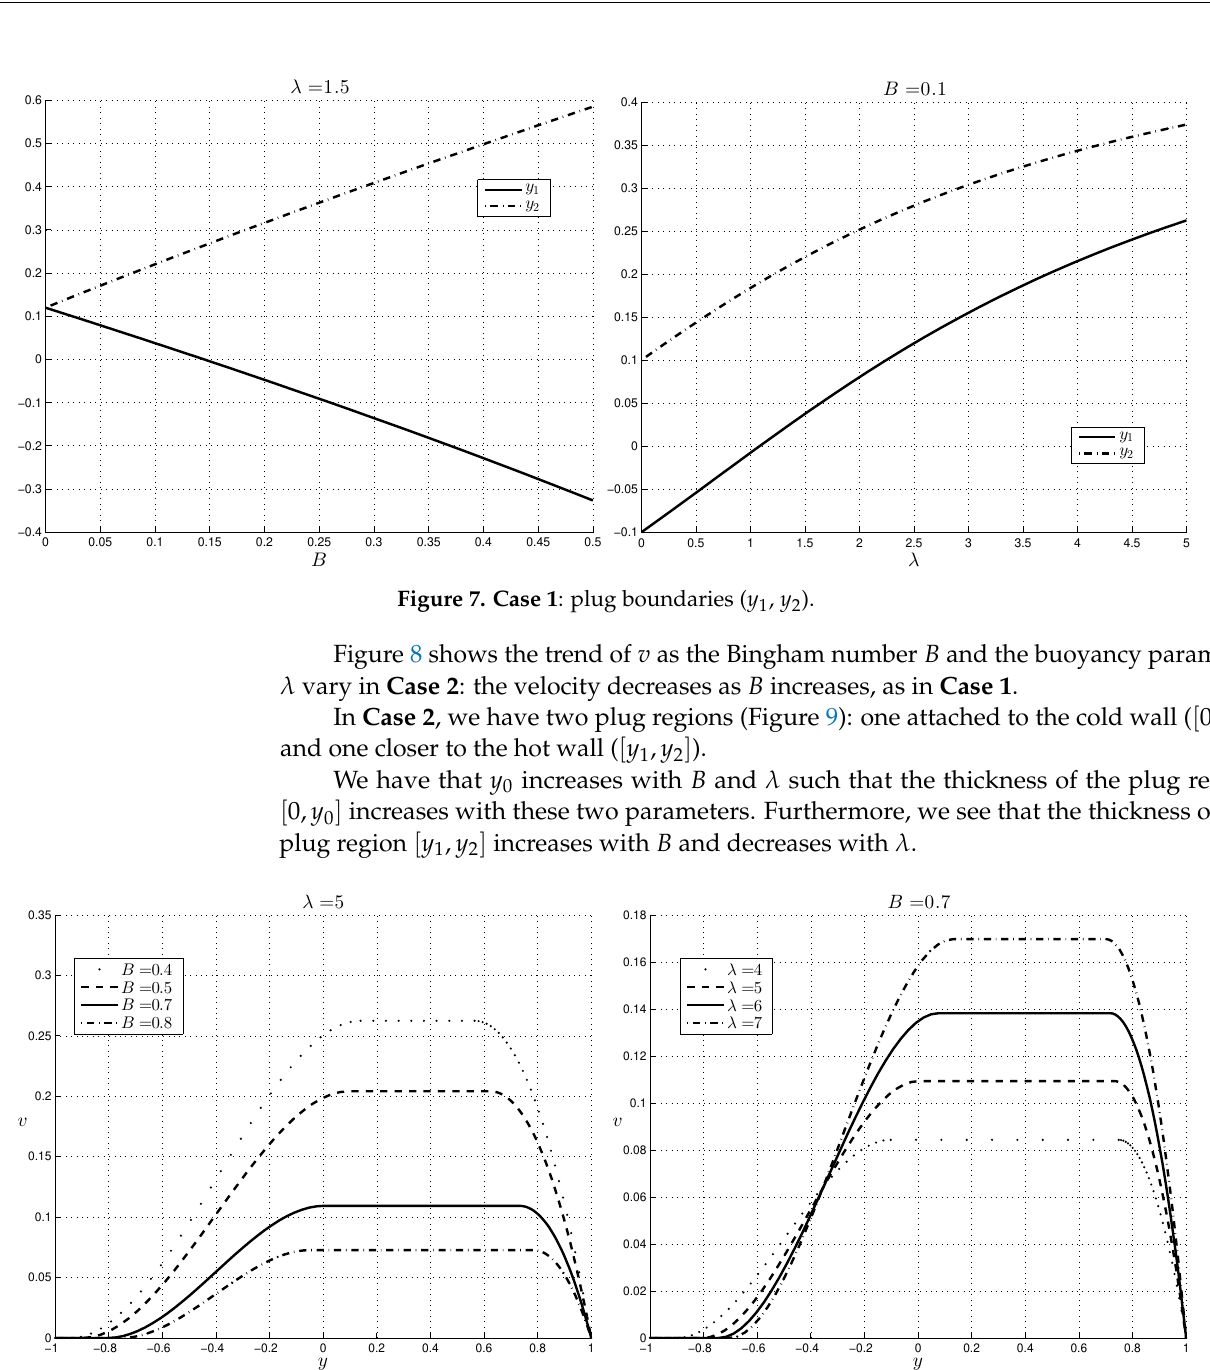
Figure 8. Case 2 : profile of the